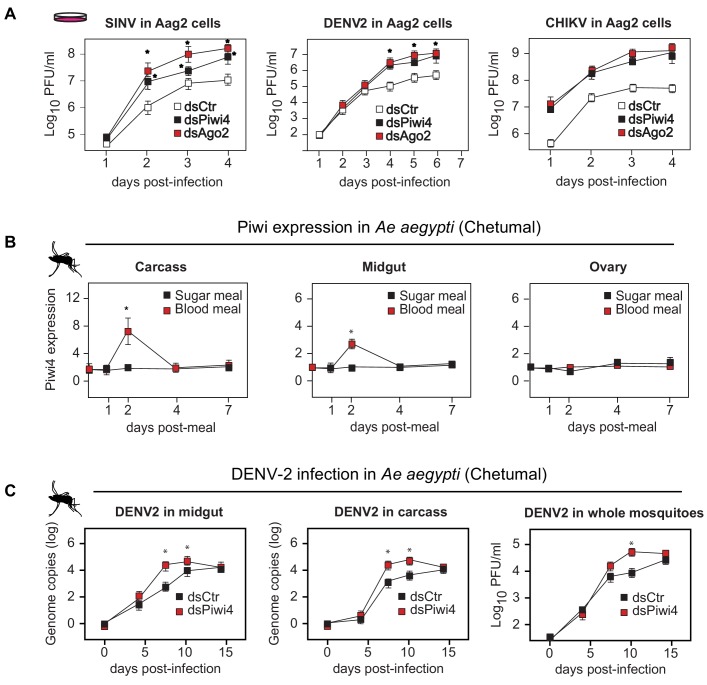
Piwi4 is a restriction factor in vivo, upregulated after blood meal.(A) Multi step growth curves of SINV, DENV-2 and CHIKV in Aag2 cells (MOI 0.1) treated with dsRNA targeting Ago2 or Piwi4 measured by plaque assay. Error bars depict standard deviation of four replicates. Significant changes over controls are marked with asterisks (p<0.05, Mann-Whitney U test). (B) Piwi4 mRNA measured by RT-qPCR from pools of either blood- or sugar- fed Ae. aegypti mosquitoes. The mean and standard deviation of four biological replicates of pools of five mosquitoes in carcass, midgut and ovary are shown. Significant changes over controls are marked with asterisks (p<0.05, Mann-Whitney U test). (C) Replication of DENV2 as measured by RT-qPCR or virus plaque assays. Mosquitoes were infected by intrathoracic injection with either dsPiwi4 or control dsRNA prior to infection. Error bars correspond to standard error of 20 (RT-qPCR) or 30 (plaque assays) biological replicates of individual mosquitoes. Significant changes over controls are marked with asterisks (p<0.05, Mann-Whitney U test).